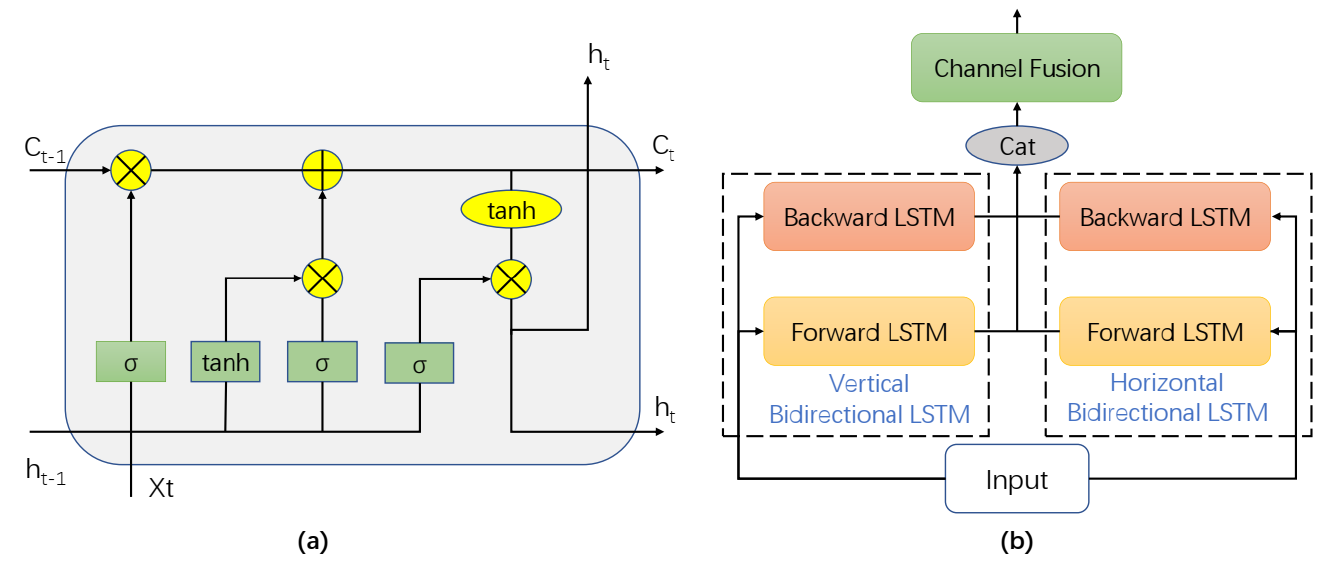
Figure 2. ( a ) The specific structure of LSTM layer ( b ) The figure outlines the BiLSTM2D layer. The LSTM [42] has an input gate i t , a forget gate f t , and an output gate o t . Where